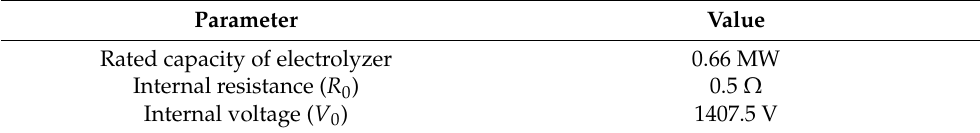
Table 1. Parameters of the electrolyzer [6].